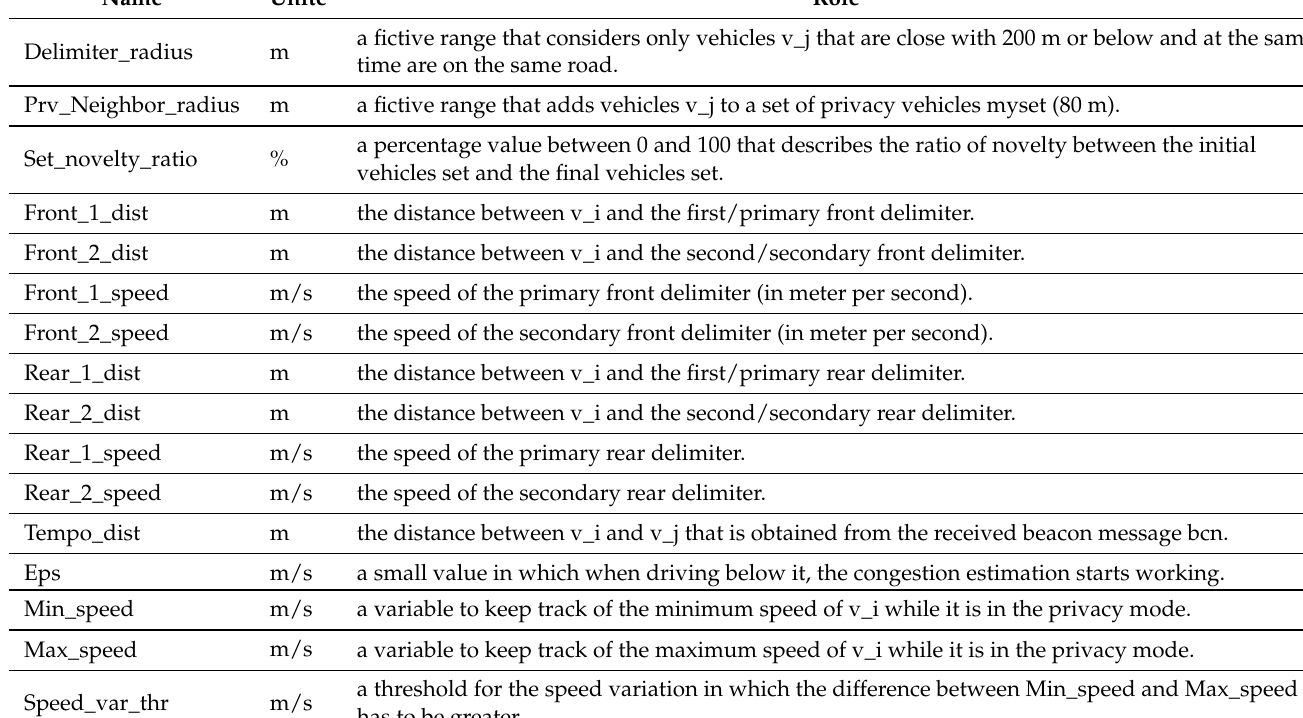
Table 1. The used terminologies in OVR for the double